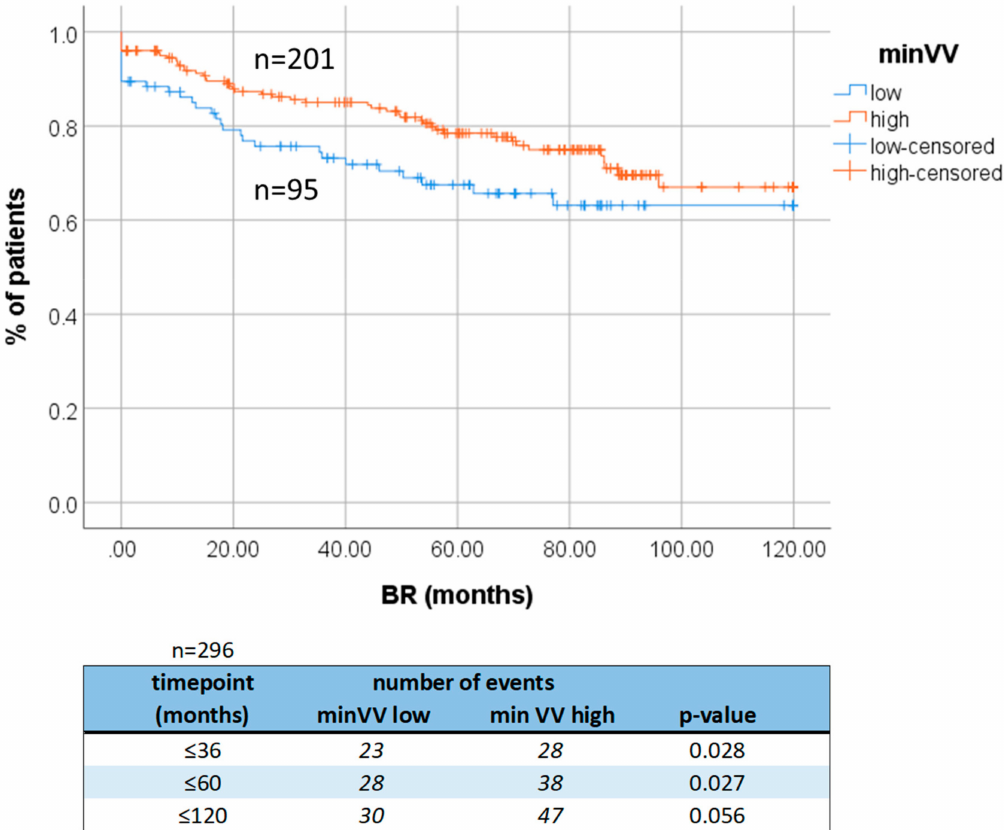
Figure 2. Survival analysis. Association of minVV to shorter time to biochemical recurrence in hormone-naïve PCa patients. BR: biochemical recurrence. VV indicates vascular vessels. Table 1. Multivariate analysis. Statistically significant results are bolded. PSA: prostate-specific antigen, minVV low —low number of vascular vessels, minVV high —high number of vascular vessels. Univariate Analysis Multivariate 5 Years